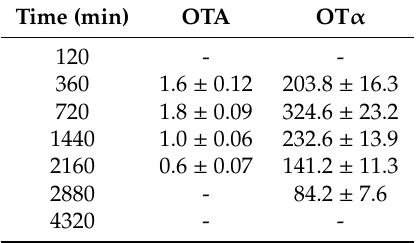
Table 4. The concentrations of ochratoxin A (OTA) and ochratoxin α (OT α ) in urine samples